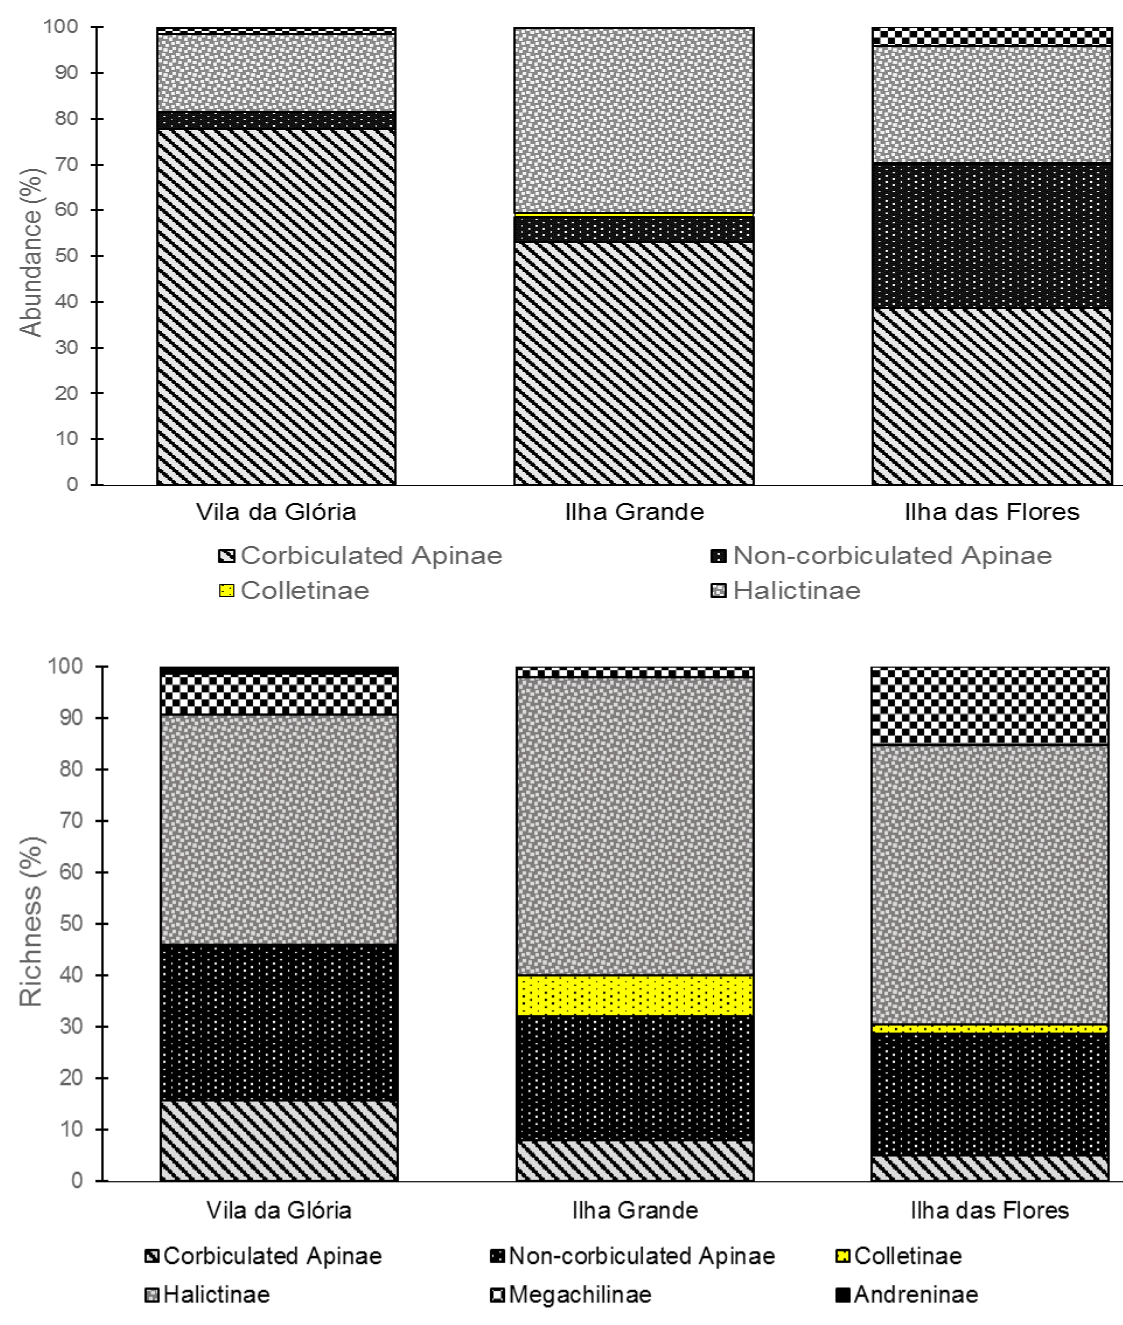
Fig 5 . Abundance and relative richness of subfamilies in the communities Vila da Glória (Mouga et al. 2015), Ilha Grande and Ilha das Flores (Mouga et al.,